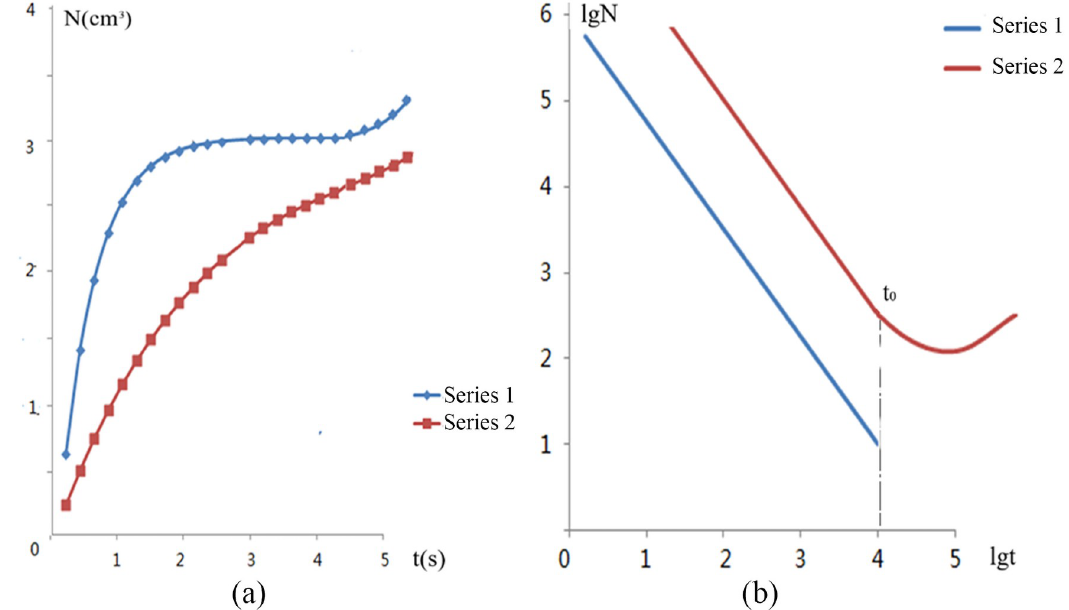
Fig 10. Granite compression experiment. (a) Fracture accumulation under uniaxial pressure. Curve 1, 1- σ = 85 MPa; Curve 2, 2- σ = 11 MPa. (b) Intersection of fracture formation velocity with time under normal pressure. Curve 1, 1- σ = 85 MPa; Curve 2, 2- σ = 11